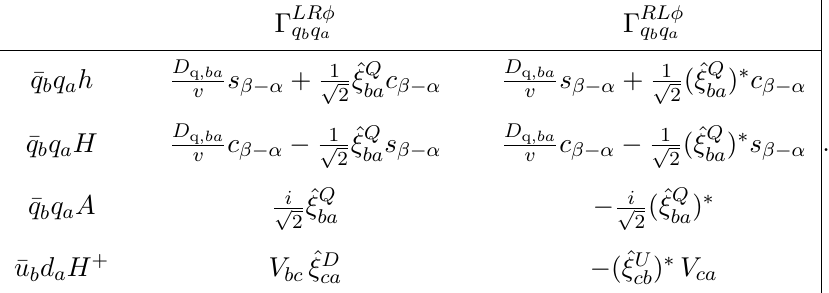
Table 4 . Scalar-quark-quark couplings extracted from eq. (3.16) using the convention of eq. (3.17), where Q = D; U